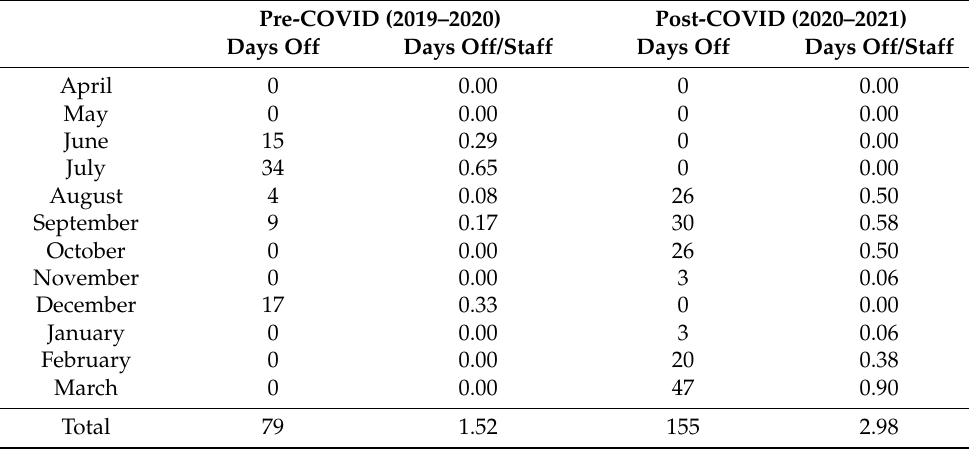
Table 4. Annual days-off taken by the staff during the pre-COVID-19 and post-COVID-19